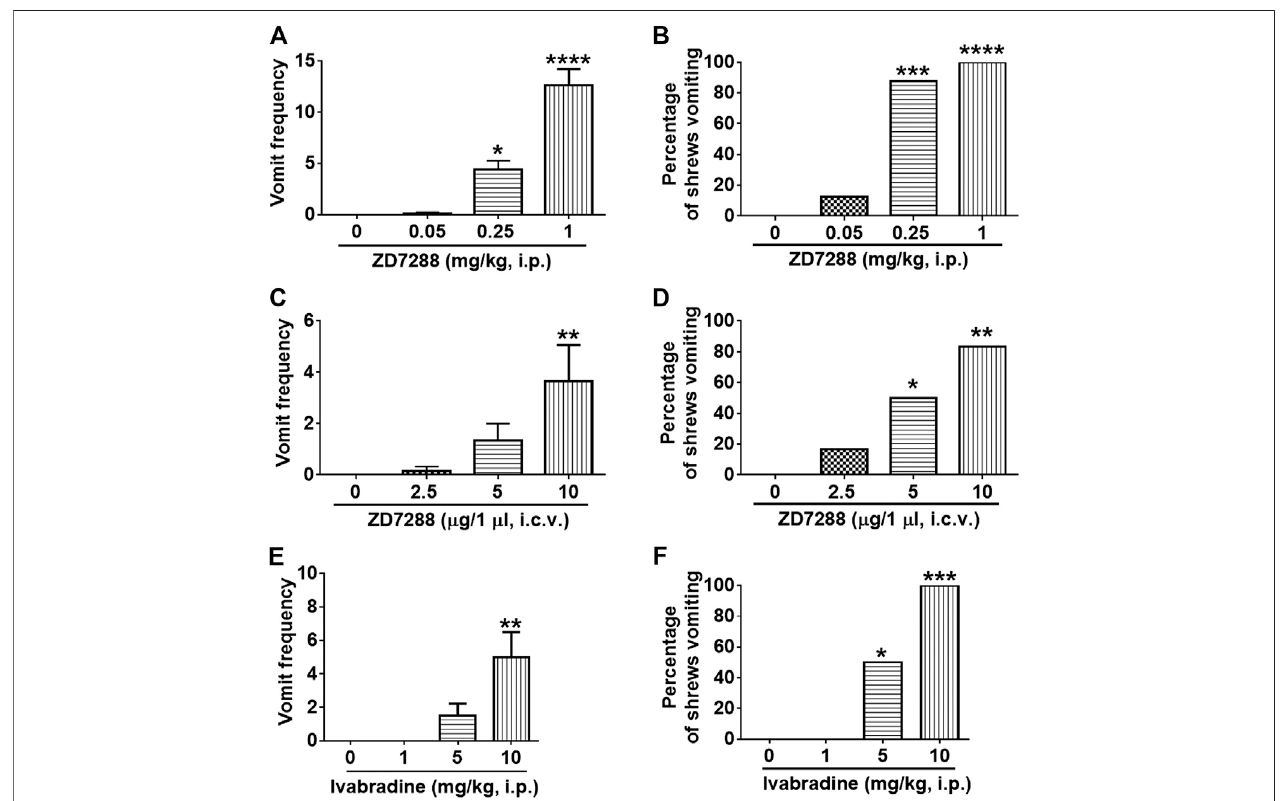
FIGURE3| Thedose-responseemeticeffectoftheHCNblockersintheleaseshrew.DifferentgroupsofleastshrewsweregivenvaryingdosesofZD7288(i.p., n (cid:2) 8 shrews per group or i. c.v., n (cid:2) 6) or ivabradine hydrochloride (i.p., n (cid:2) 6 shrews per group), and were observed for the next 30 min (A, C, E) The frequency of emesis was analyzed with Kruskal-Wallis non-parametric one-way ANOVA followed by Dunnett ’ s post hoc test and presented as mean ± SEM. (B, D, F) Percentage of shrews vomiting was analyzed with chi-square test and presented as mean. * p < 0.05, ** p < 0.01, *** p < 0.001, **** p < 0.0001 vs. 0 mg/kg.